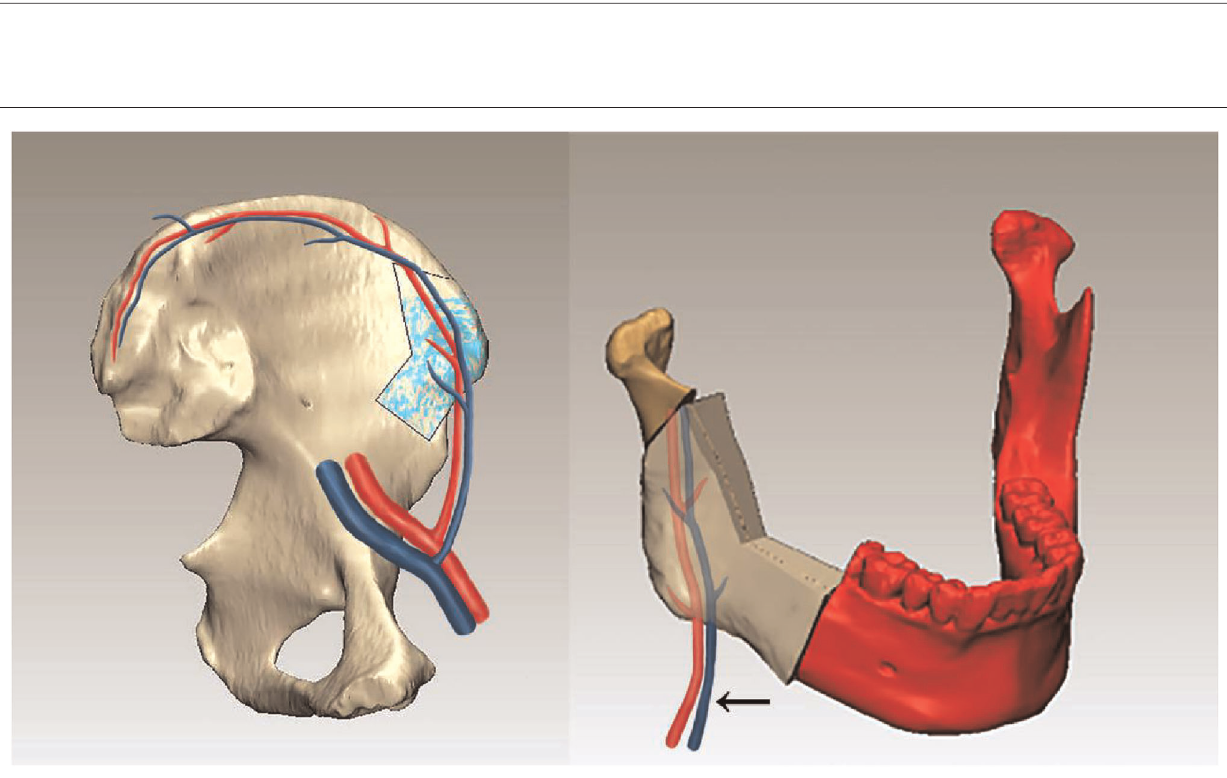
FIGURE 7 | Sketch map showing the relationship between the vessel pedicle and the iliac bone graft; the arrow shows that this design could avoid the twist of the vessel pedicle and keep it in a line when the iliac bone fl ap was transferred to the mandible defect